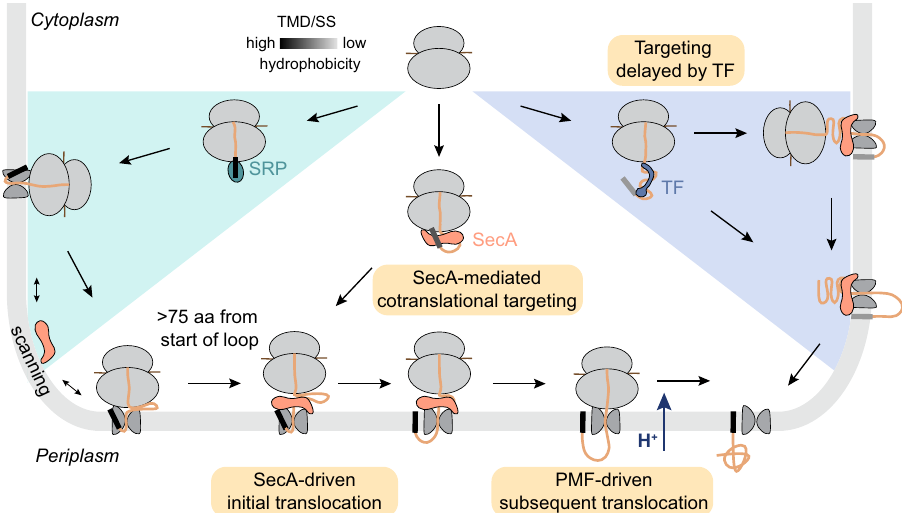
Fig. 7 Model of cotranslational SecA engagement during protein transport. Proteins with highly hydrophobic N-terminal signals, including most IMPs and a few secretory proteins, are recognized and targeted to the membrane by SRP. Large periplasmic loops on IMPs cannot be translocated across SecYEG, and thus accumulate at the cytoplasmic surface and disrupts the ribosome-SecYEG junction when >75 amino acids of the periplasmic loop is translated. SecA then gains access to these stalled translocating complexes, uses its ATPase cycle to drive the initial translocation of the loop across SecYEG and restores the ribosome-SecYEG junction. Subsequence translocation is driven by PMF or other forces. Secretory proteins with weakly hydrophobic signal sequences are recognized by TF at a nascent chain length of ~100 amino acids. TF delays their engagement by SecA until protein synthesis is close to complete, thus enforcing a mechanistically posttranslational mode of their export. The other ~25% of secretory proteins with more hydrophobic signal sequences engage with SecA at a nascent chain length of ~100 amino acids. They are possibly targeted to the membrane by SecA, and are translocated across SecYEG in a manner analogous to the translocation of large periplasmic loops on